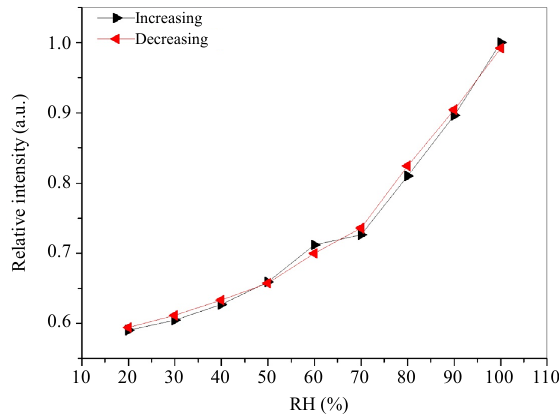
Fig. 10 Reversibility of the sensor at room